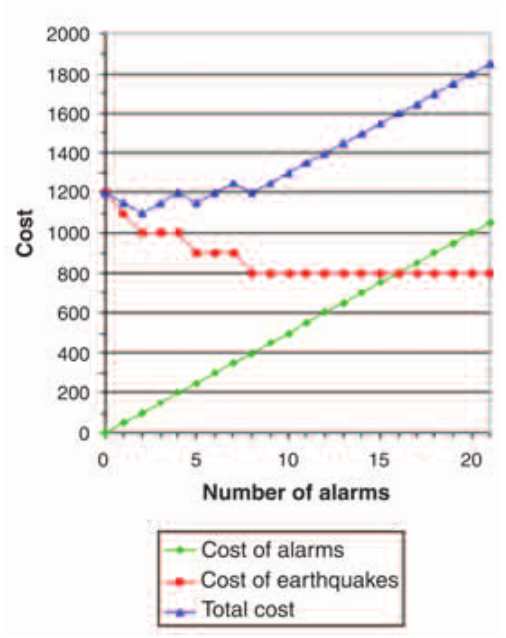
Fig. 6. Cost of alarms, cost of earthquakes, and total cost computed for the realization of the earthquake process shown in fig. 1, versus the number of alarms issued, following the criterion of issuing only alarms for the periods of time characterised by a theoretical probability taken in reverse